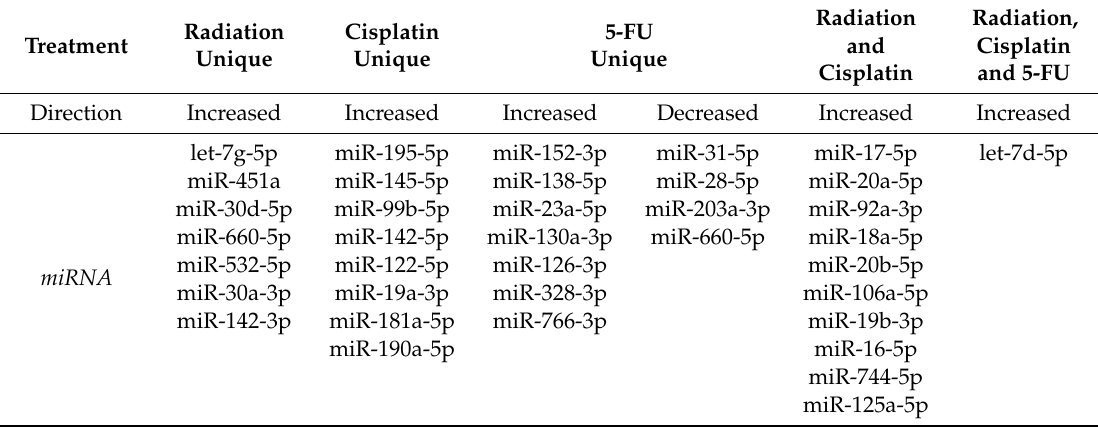
Table 4. miRNA sets associated with resistance to di ff erent treatment modalities. Criteria for a unique treatment association were a Spearman p < 0.05 for one agent AND Spearman p ≥ 0.1 AND t -test p ≥ 0.1 for the other two agents (or if the direction of expression was